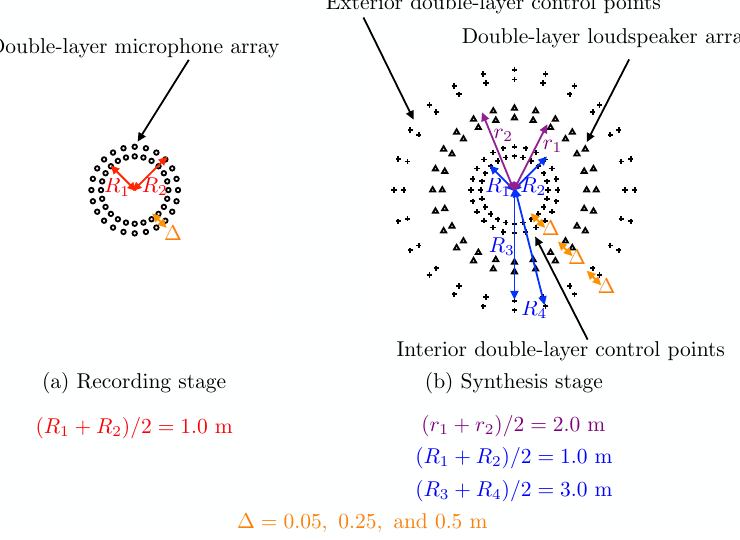
Figure 5. Computer simulations conditions: ( a ) double-layer microphone array; and ( b ) double-layer arrays of loudspeakers and control points. Each layer has 24 elements with equiangular